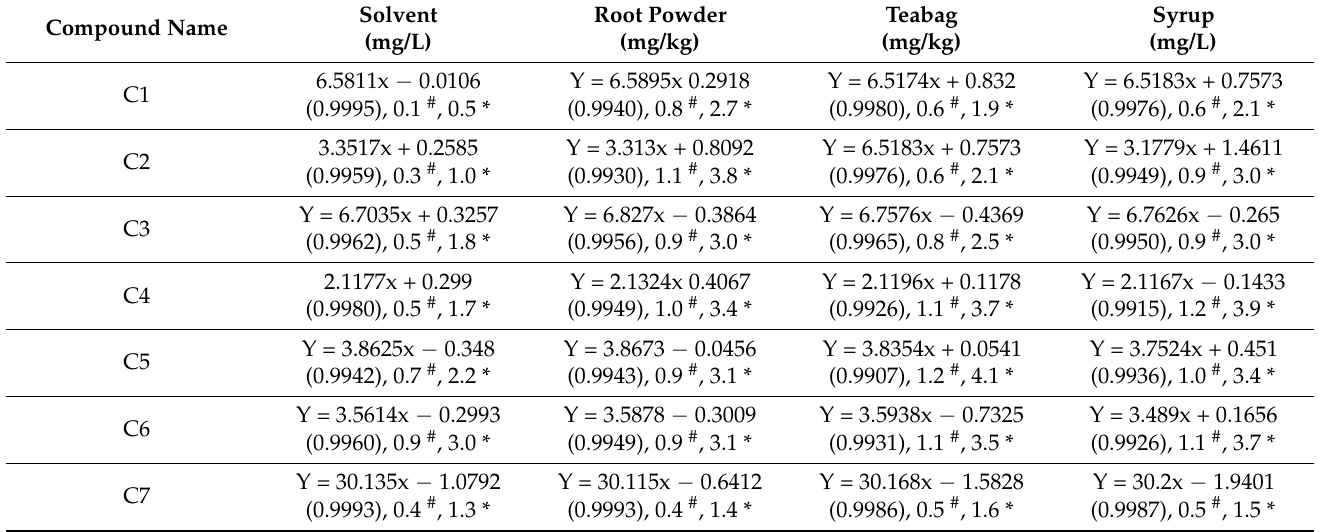
Table 3. Linearity data (regression coefficient), limit of detection # and limit of quantification * using the external standard- calibration and standard-addition